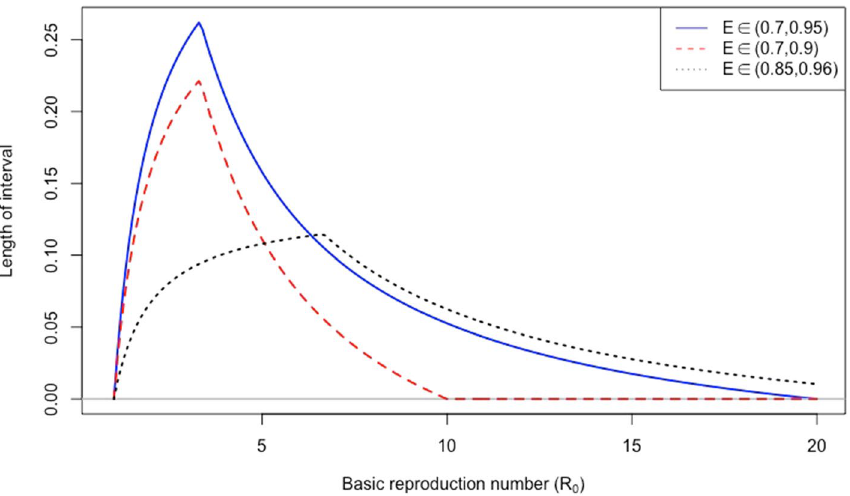
Figure 2. Illustration of the length of the interval (4) as a function of R 0 for three different scenarios: the blue solid curve represents vaccine effectivenesses between 0.7 and 0.95; the red dashed curve represents effectivenesses between 0.7 and 0.9; the black dotted curve represents effectivenesses between 0.85 and 0.96. The first and second scenarios have a peak at the same point with different heights. However, the third scenario has a peak at a larger R 0 value with a smaller height at its peak. Hence the third set of vaccines is effective for a larger range of reproduction numbers, and the difference between the least and the most favourable strategies is smaller than other